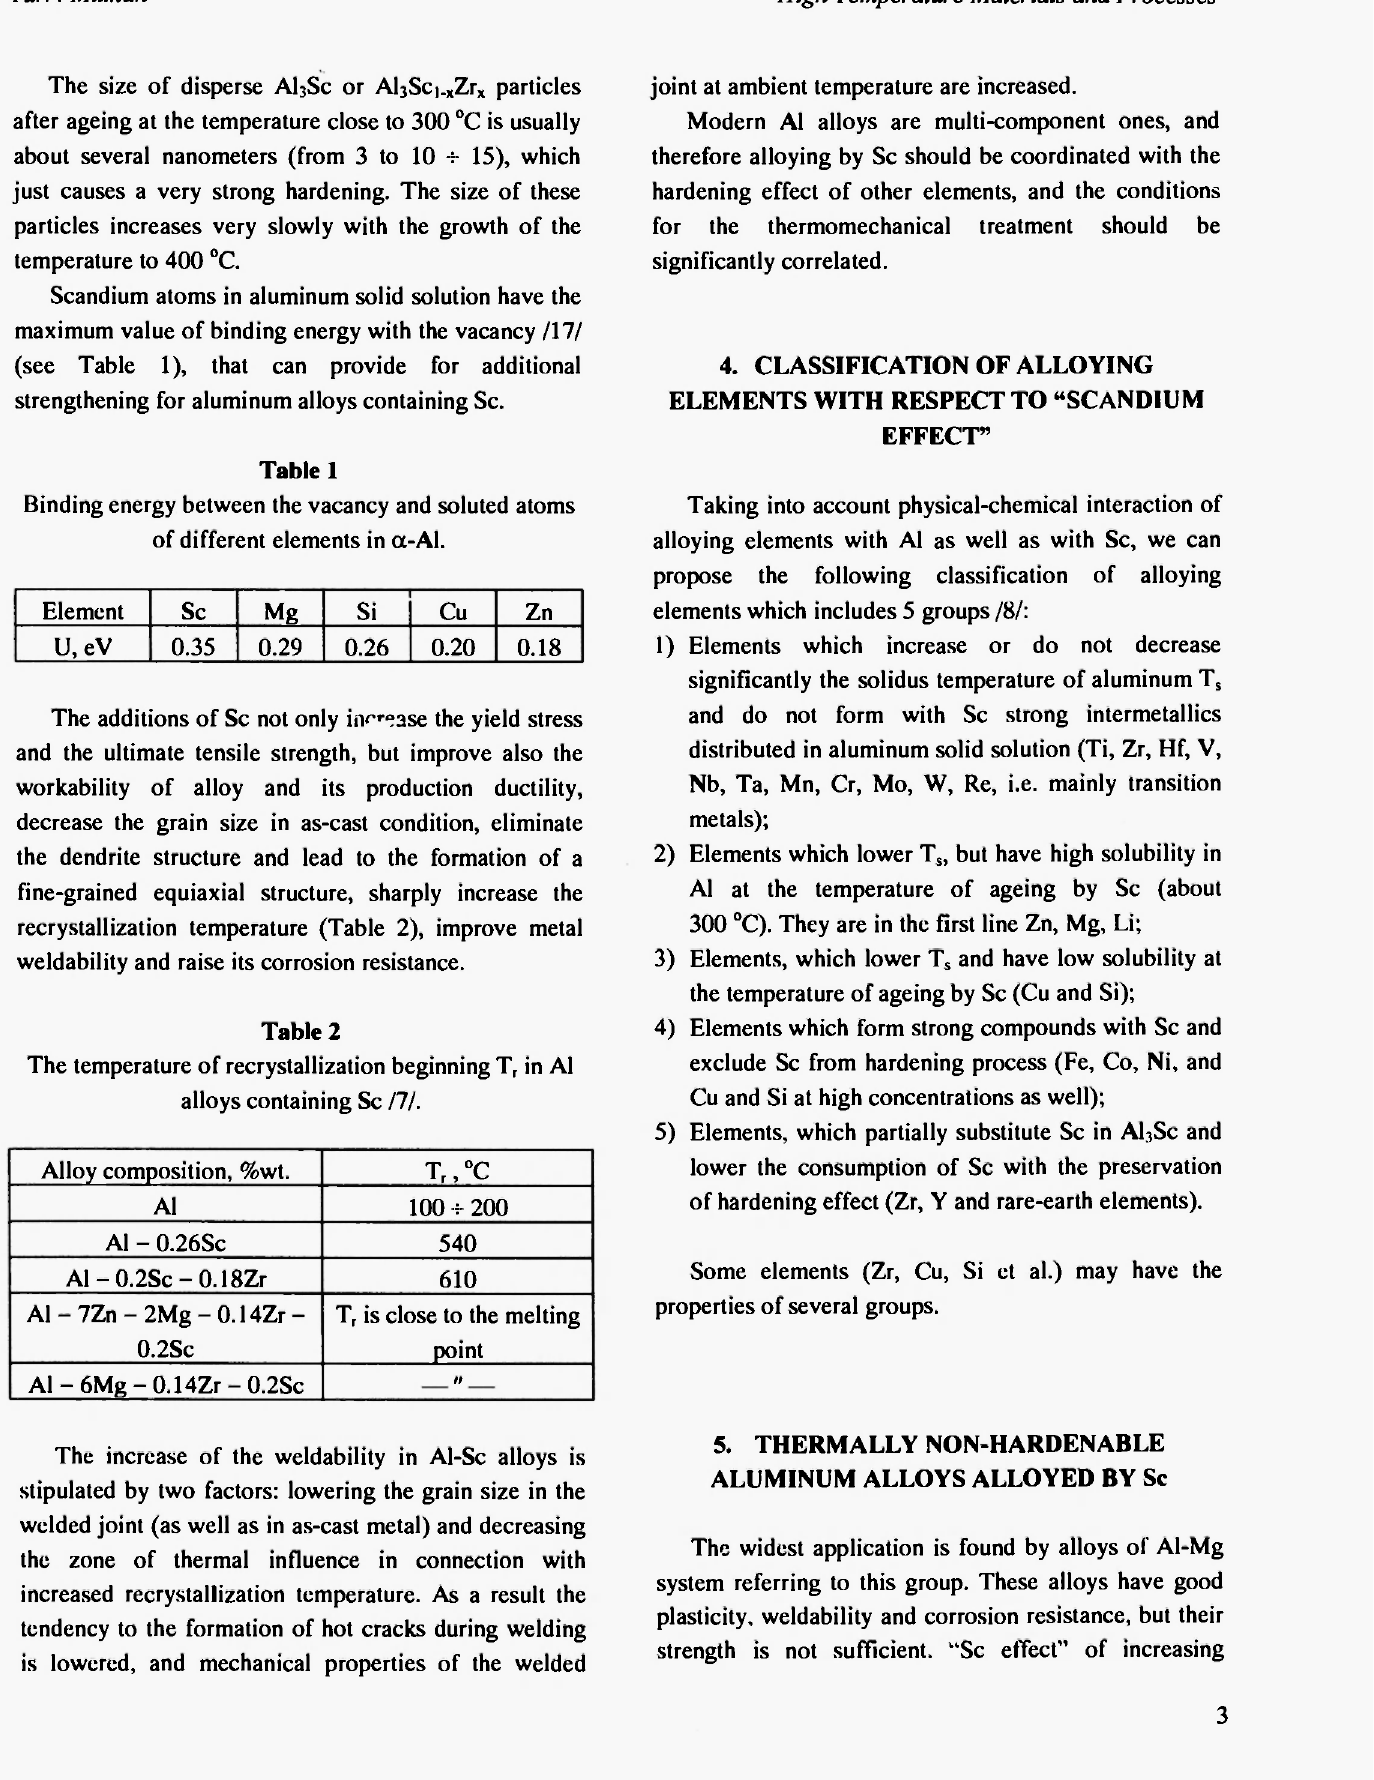
The temperature of recrystallization beginning T r in Al alloys containing Sc